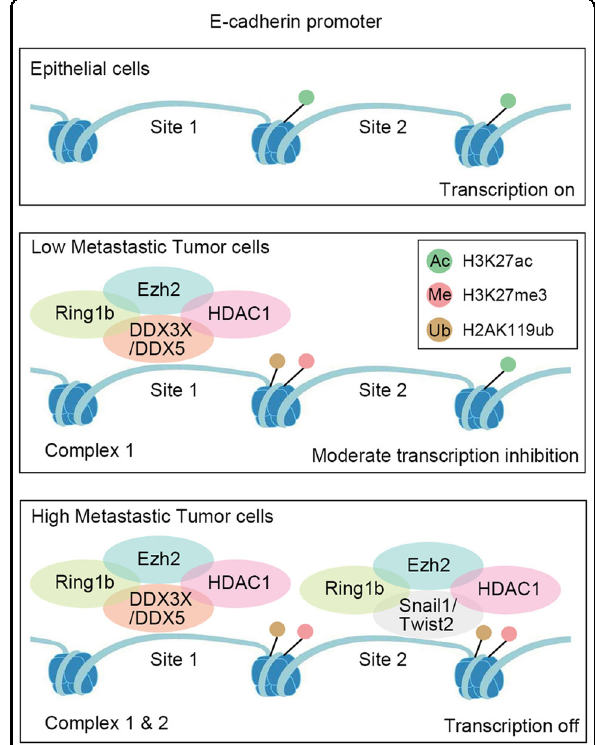
Fig. 7 Schematic diagram of Ring1b-dependent epigenetic remodeling for E-cadherin transcription in breast cell lines. Distinct Ring1b complexes gradually make breast cells lose the expression of E-cadherin, change epigenetic markers on the E- cadherin promoter and acquire metastatic